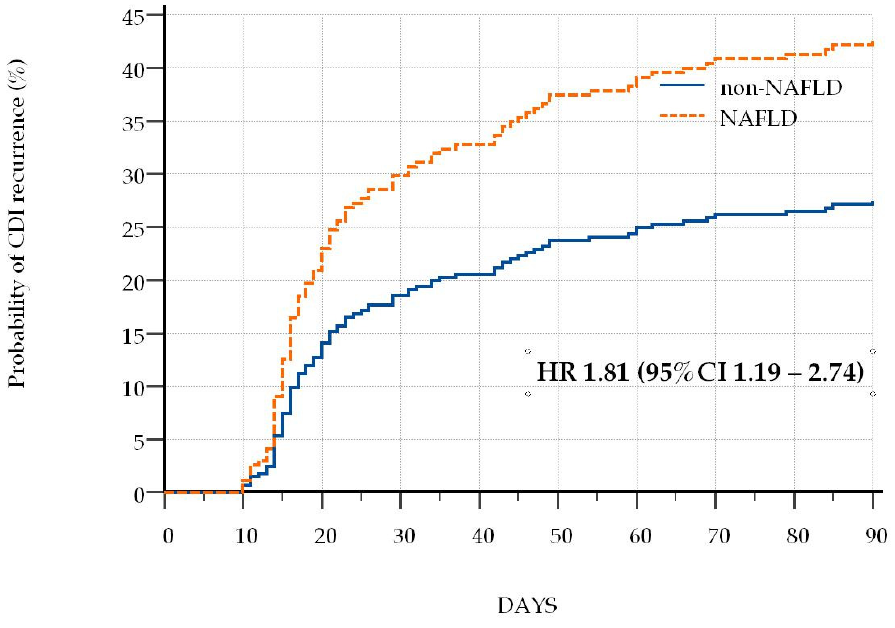
Figure 1. Kaplan–Meier curves and Cox proportional hazard ratios (HR) for recurrence of Clostrid- ioides difficile infection in patients with and without nonalcoholic fatty liver disease. Table 3. Multivariable Cox regression analysis of risk factors for the development recurrent Clos- tridioides difficile infection.